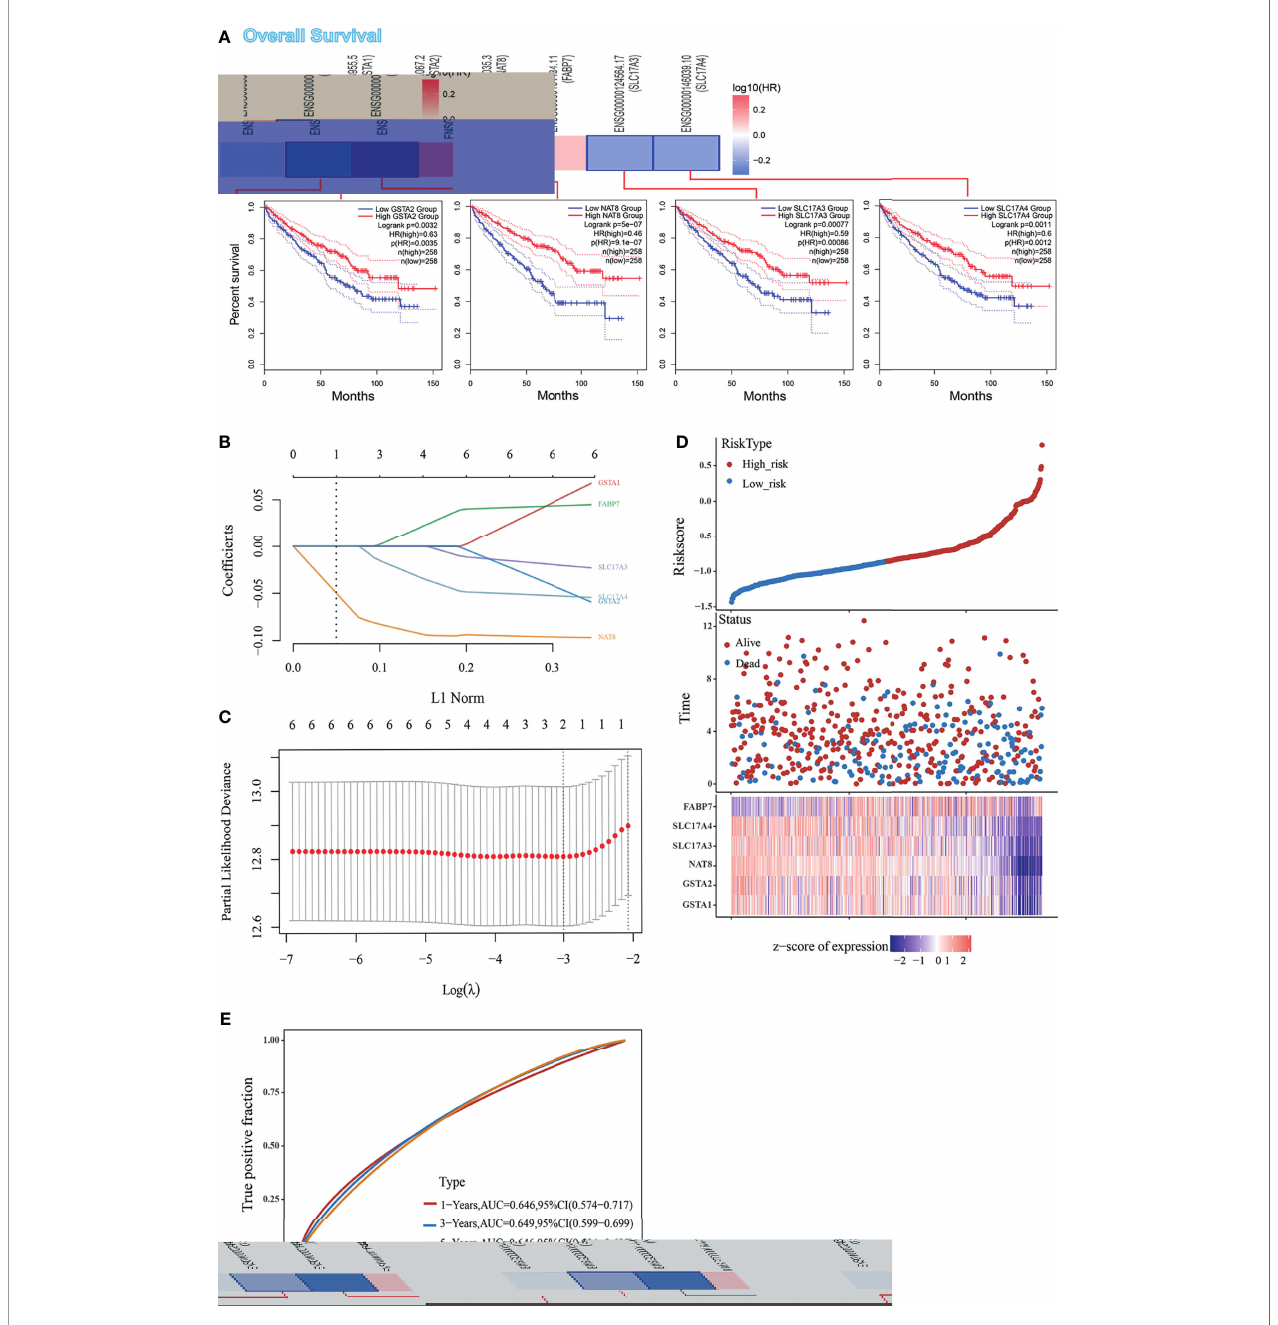
FIGURE 2 | Prognostic value of DEGs in ccRCC cohort form TCGA set, (A) The correlation between OS and DEGs expression, and Kaplan – Meier curves performed by GEPIA2 tool describes the OS. (B) Coef fi cients of DEGs are shown by lambda parameter. (C) Partial likelihood deviance versus log ( l ) was drawn using LASSO Cox regression model. (D) Patients were divided into low- and high-risk groups according to risk score (upper). Survival status of the patients (middle) and expression pro fi les of the DEGs (below) are shown corresponding to the risk score. (E) Time-dependent ROC analysis of the DEGs. The AUC value predicts the prediction ability of the